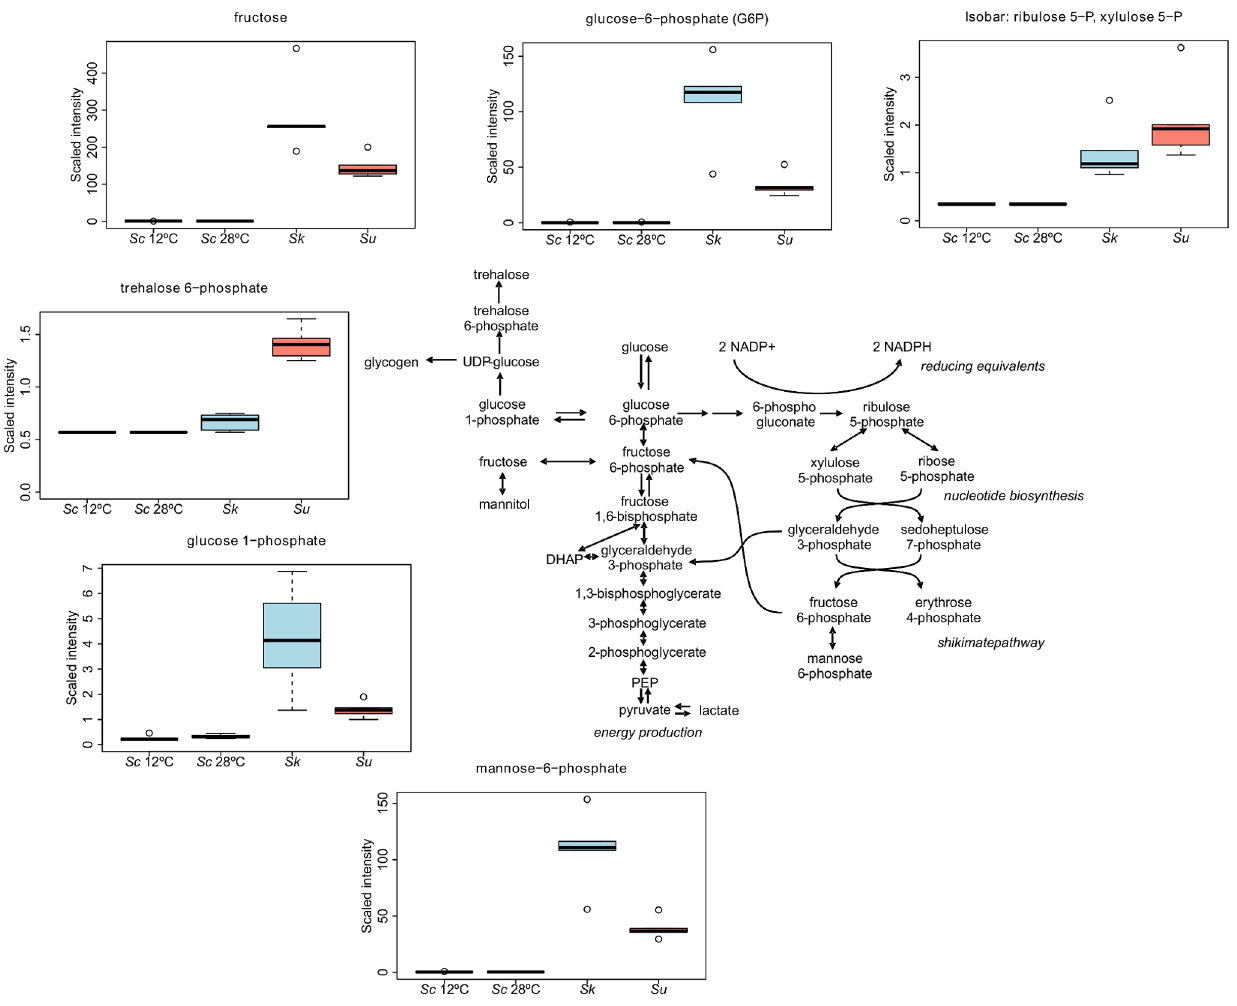
Figure 2. Carbohydrate metabolism: glycolytic pathway, trehalose synthesis, intermediates of the pentose phosphate pathway and protein mannosylation. Differentially produced metabolites within Su and Sk compared to Sc . Box legend: bar inside the box represents the median value, upper bar represents maximum of distribution, lower bar represents minimum of distribution, and the circle represents extreme data points.